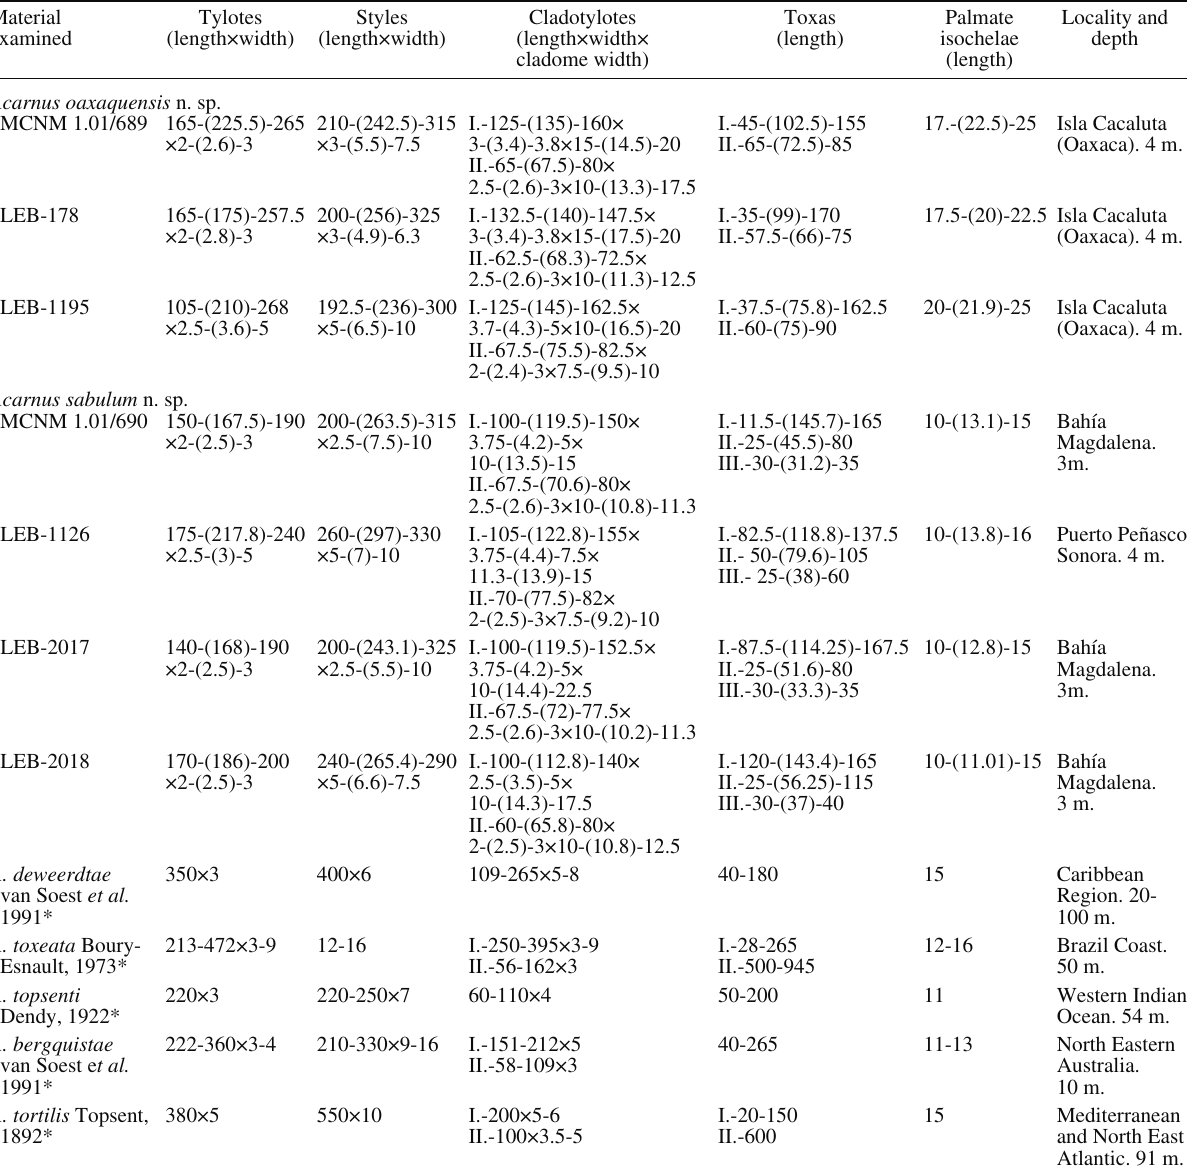
Table 3. – Comparative table data of the Acarnus species of the “tortilis” group from the Mexican Pacific and other specific worldwide locali- ties. Values are expressed in minimum-average-maximum (μm). *Spicule measurements from the original description. Material Tylotes examined